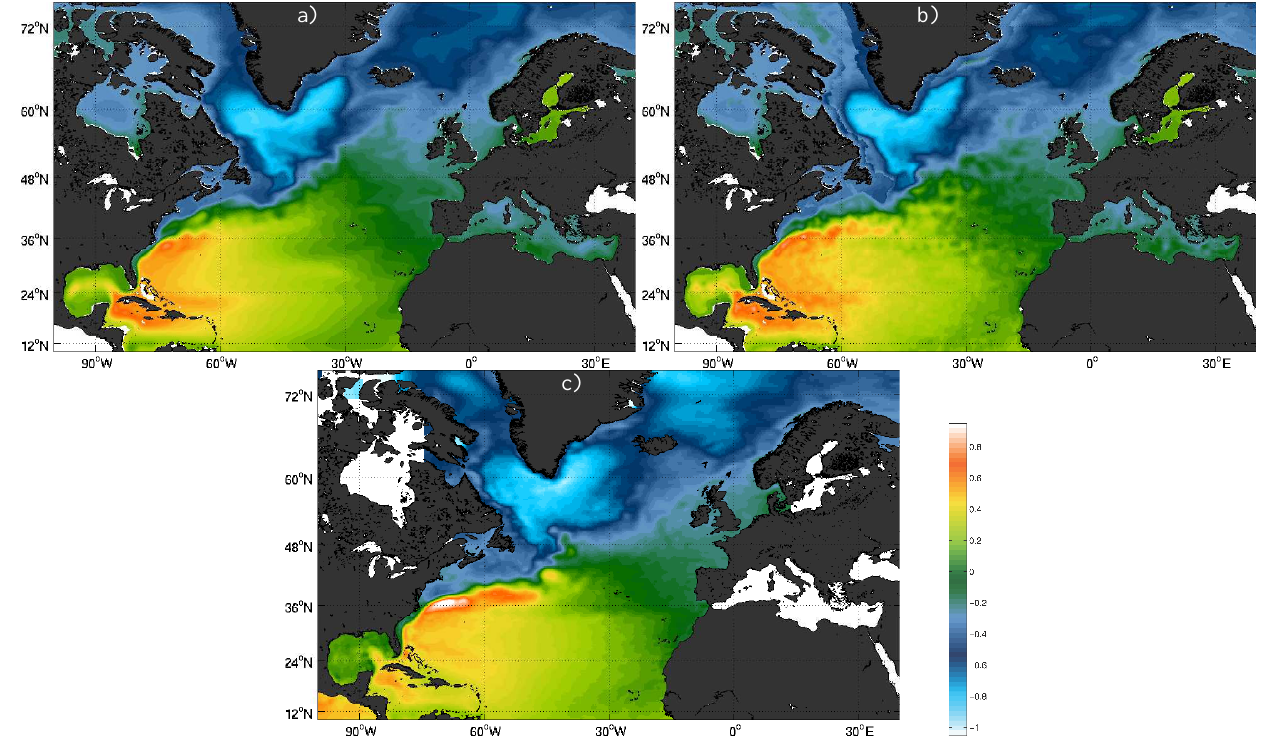
Fig. 10. (a) TOPAZ4 MSSH before bias correction; (b) TOPAZ4 MSSH after bias correction; (c) MDT from CNES-CLS09.